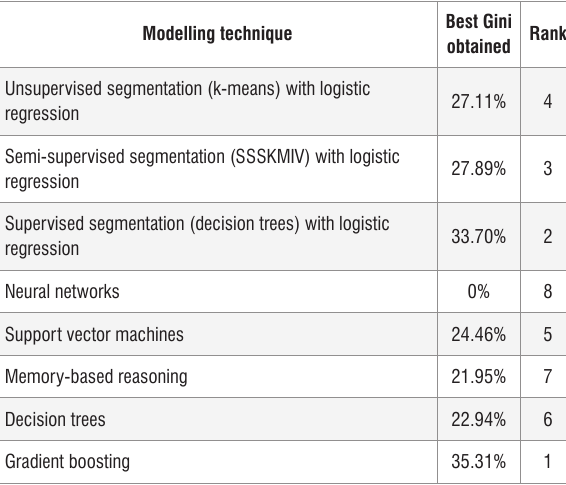
Direct marketing data set: Comparison of performance